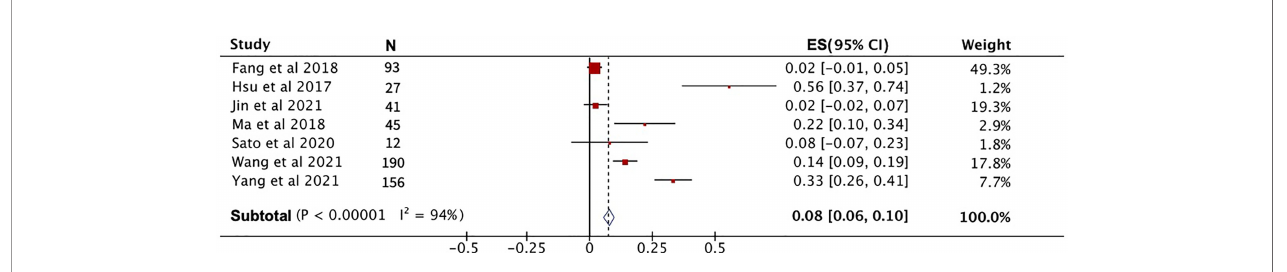
FIGURE 5 | Rate of ≥ G3 adverse events in patients receiving PD-1 treatment.